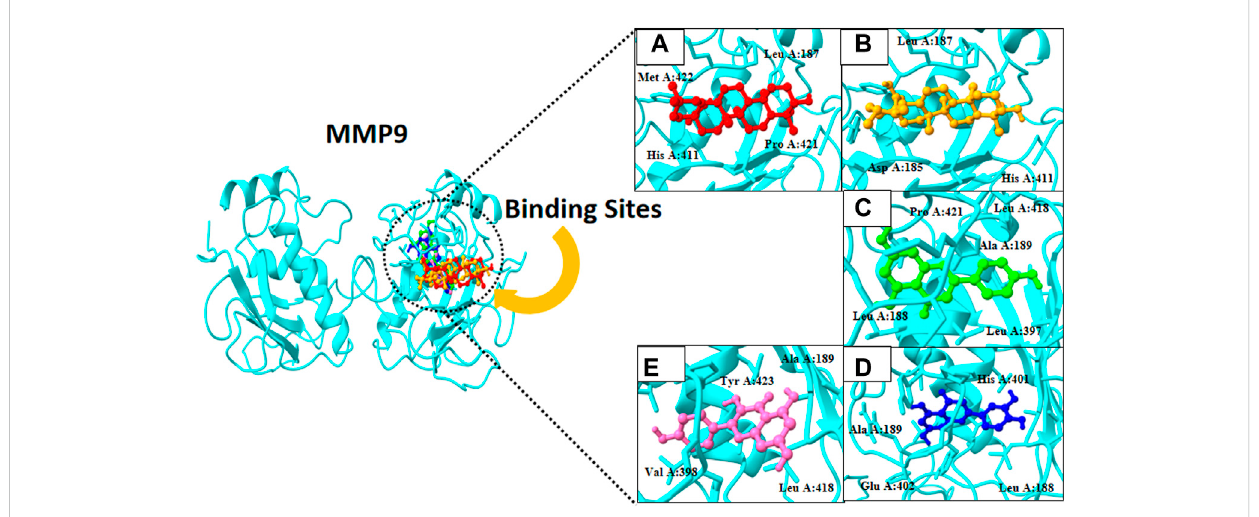
FIGURE 4 3D visualization of MMP9 protein active compounds: (A) Oleanolic acid, (B) ursolic acid, (C) apigenin, (D) oleanolic acid, and (E) kaempferol.